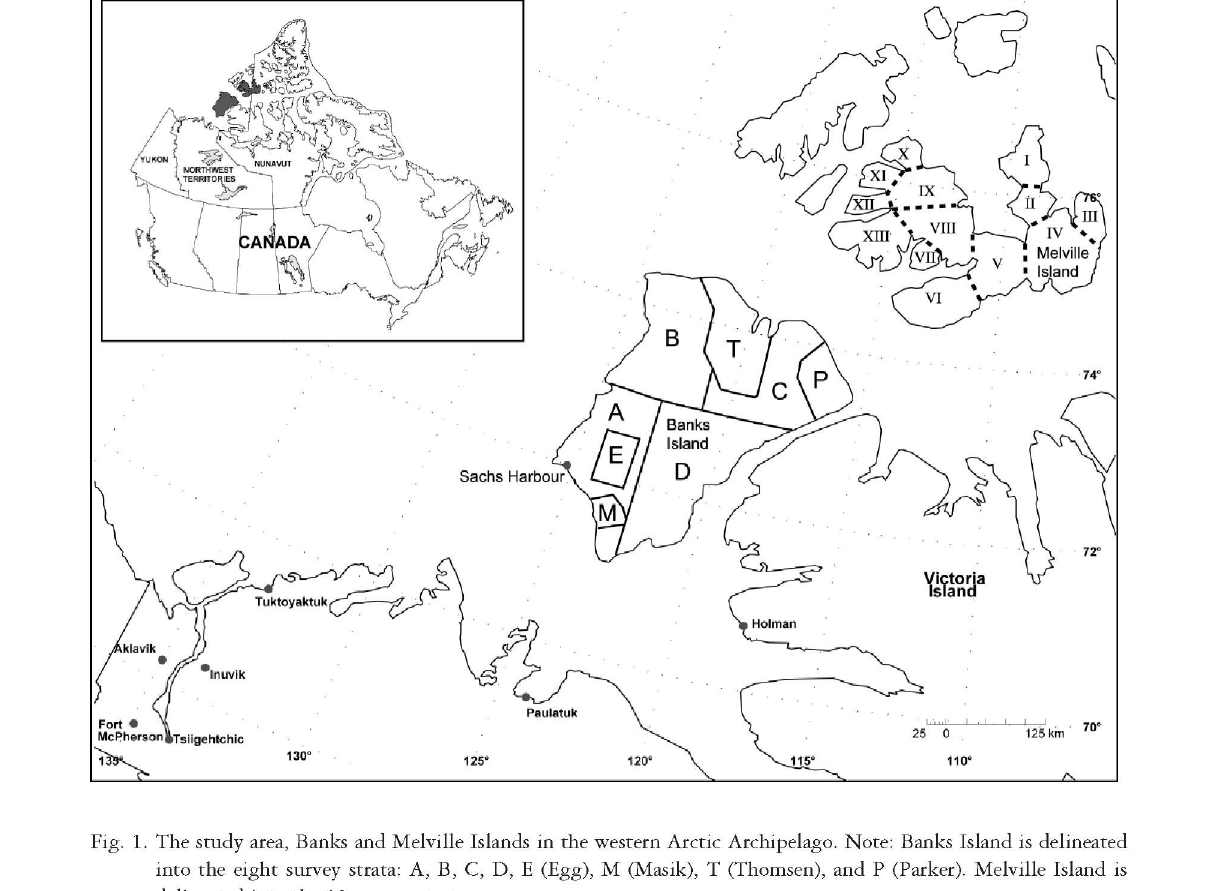
Fig. 1. The study area, Banks and Melville Islands in the western Arctic Archipelago. Note: Banks Island is delineated into the eight survey strata: A, B, C, D, E (Egg), M (Masik), T (Thomsen), and P (Parker). Melville Island is delineated into the 13 survey